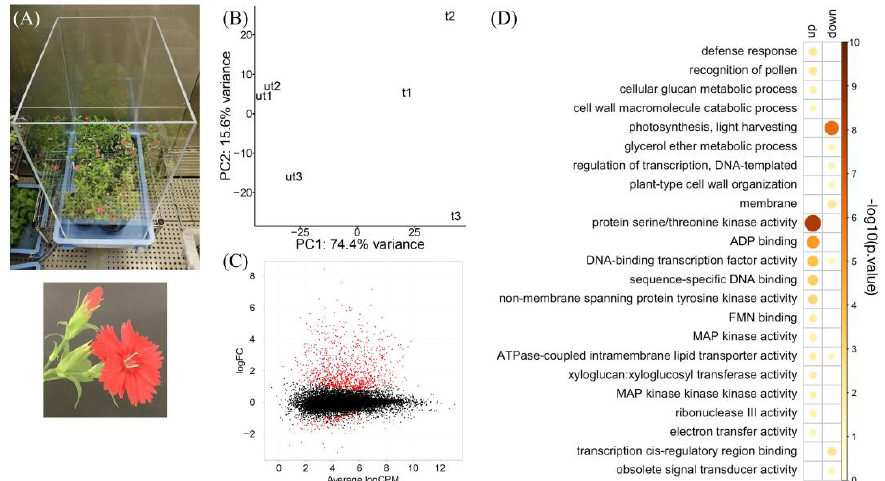
Figure 1. RNA-seq summary of touched D. hybrida flower buds. ( A ) D. hybrida plants grown in a wind- and vibration-proofed box. The bottom panel shows a flower and a bud. ( B ) PCA plot of three replicates each of touched (t) and untouched (ut) samples using uniquely mapped reads. ( C ) MA plot of expressed genes (TPM > 2.5 at least in all three replicates of either touched or untouched sample). Red dots indicate DEGs (FDR < 0.001). ( D ) GO enrichment analysis of DEGs.